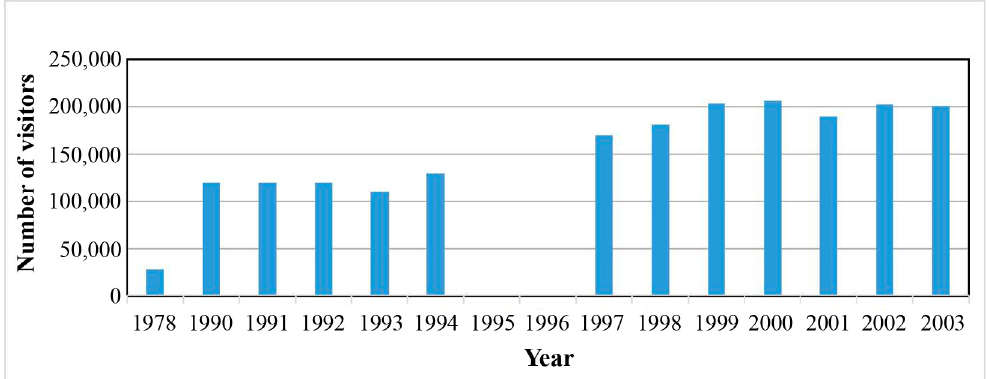
Figure 1. Number of visitors every year to Walpole-Nornalup National Park. Note: The data were not collected in 1995 and 1996 (Source: author remade according to reference [30]).